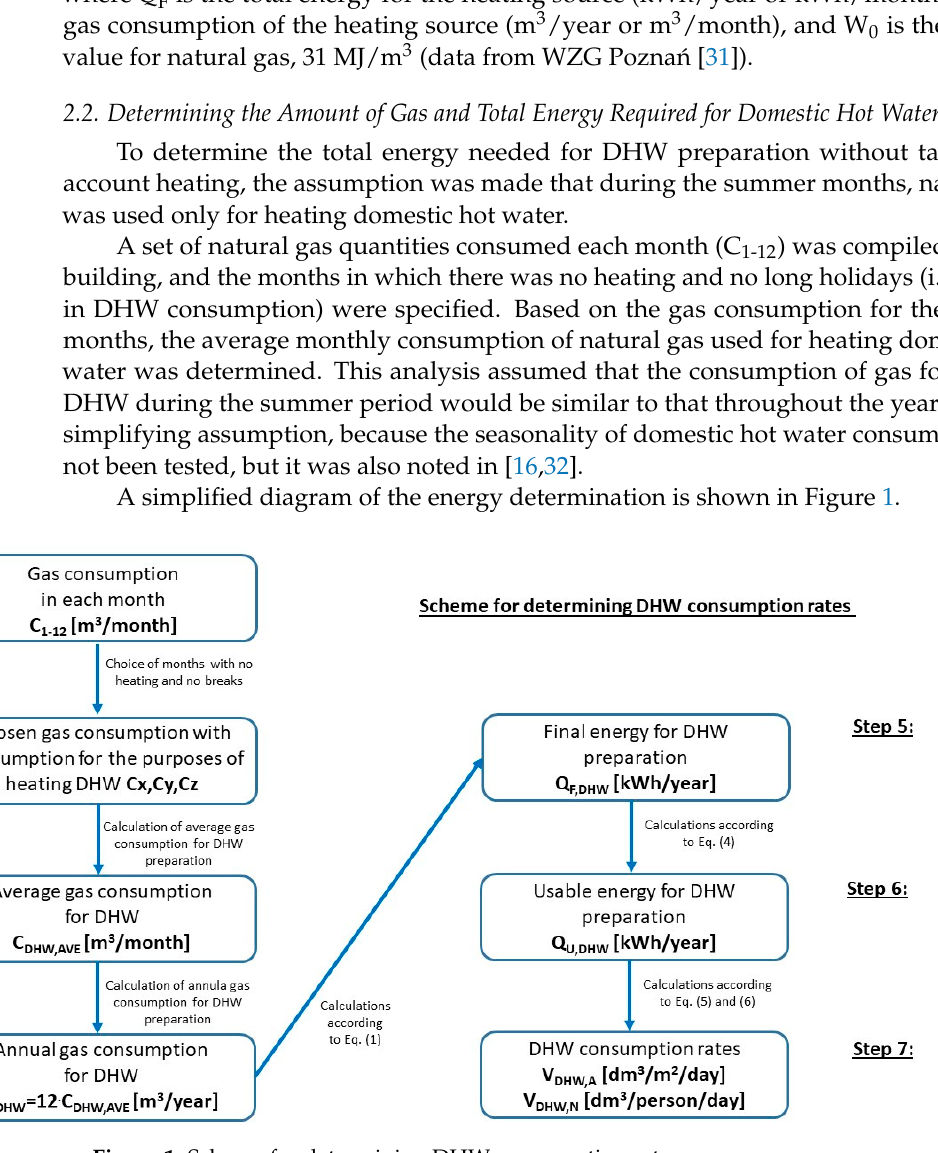
Figure 1. Scheme for determining DHW consumption rates.